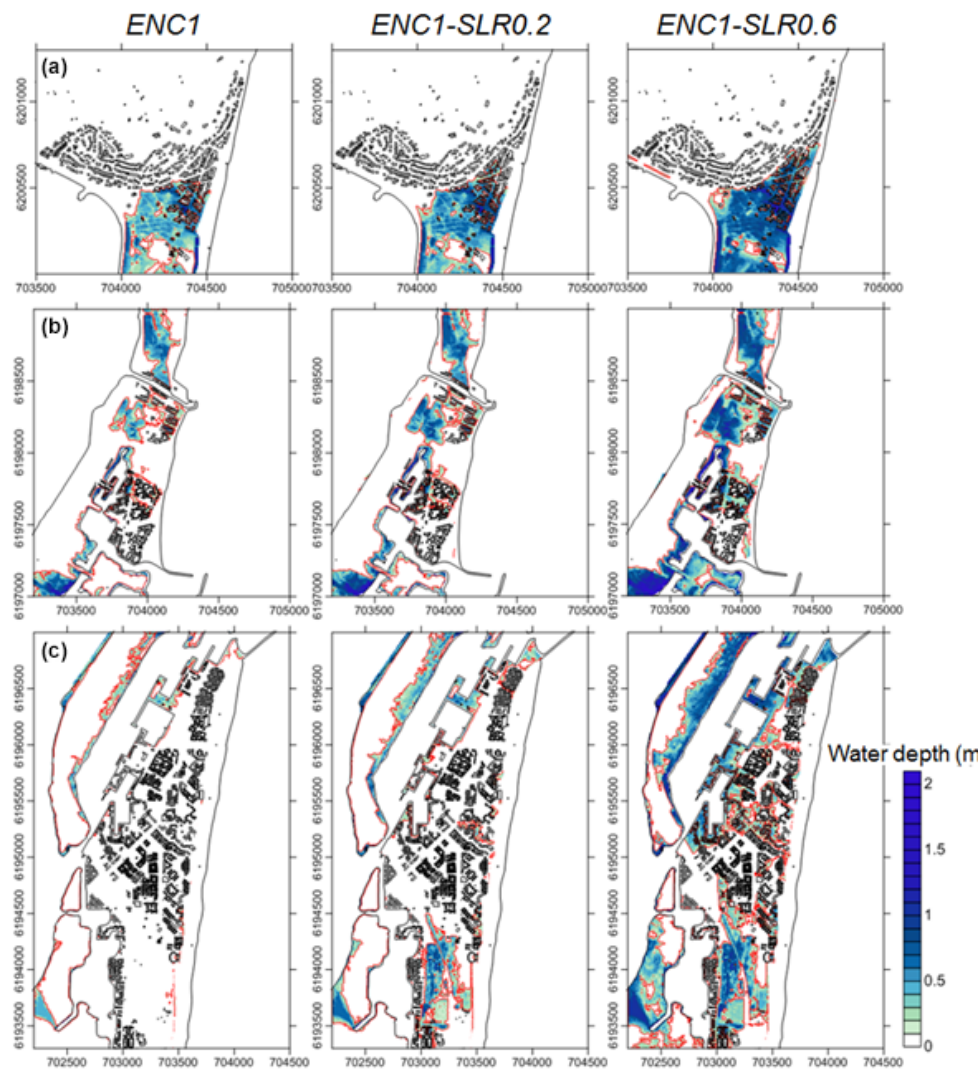
Figure 11. Results for the most impacting 100-year scenarios: ENC1 (environmental contour method – scenario 1), ENC1-SLR0.2 (for mean sea level rise of 20cm) and ENC1-SLR0.6 (for mean sea level rise of 60cm). Red line represents the maximal flood